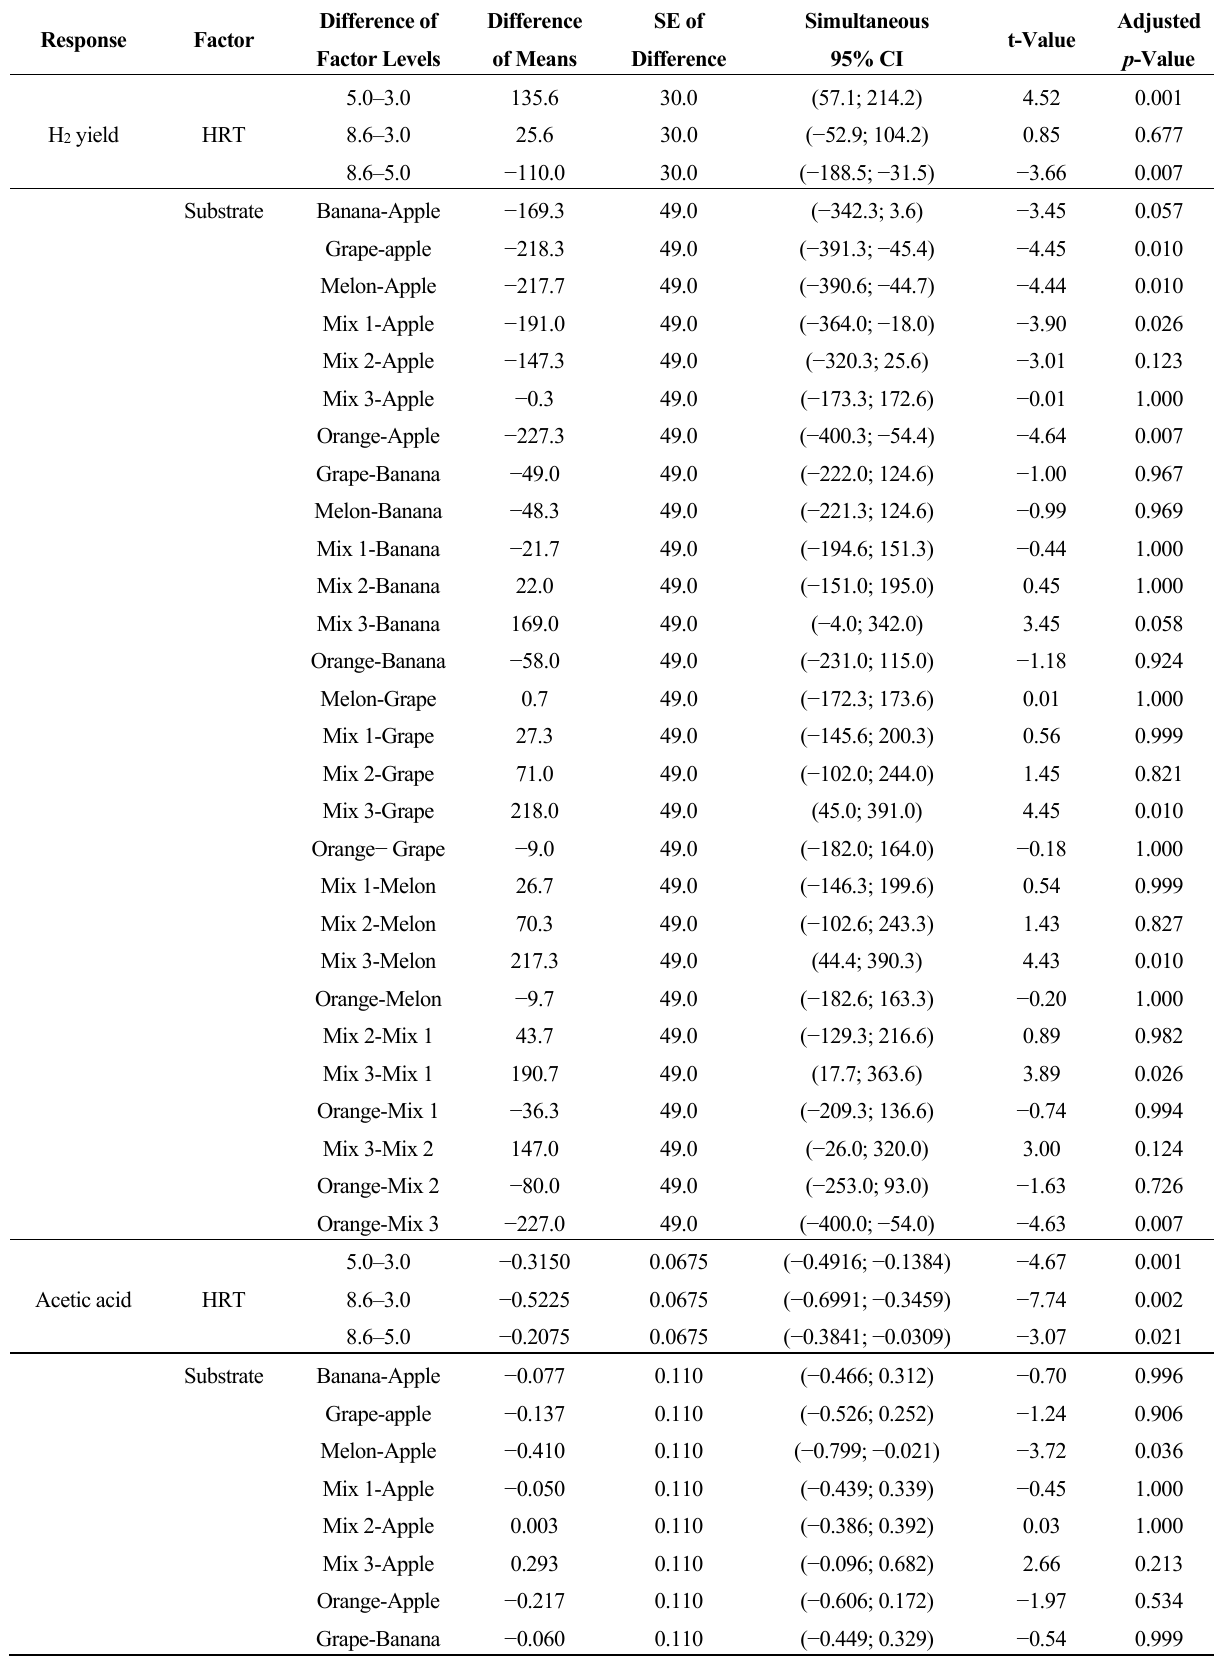
Table 6. Tukey pairwise comparisons: Response = H 2 yield, acetic acid production; factor = HRT,